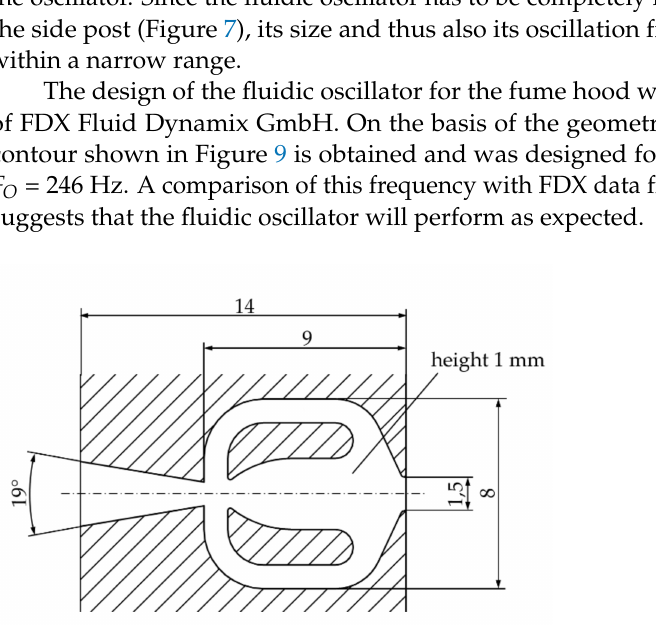
Figure 9. Main dimensions and internal contour of the fluidic oscillator for the fume